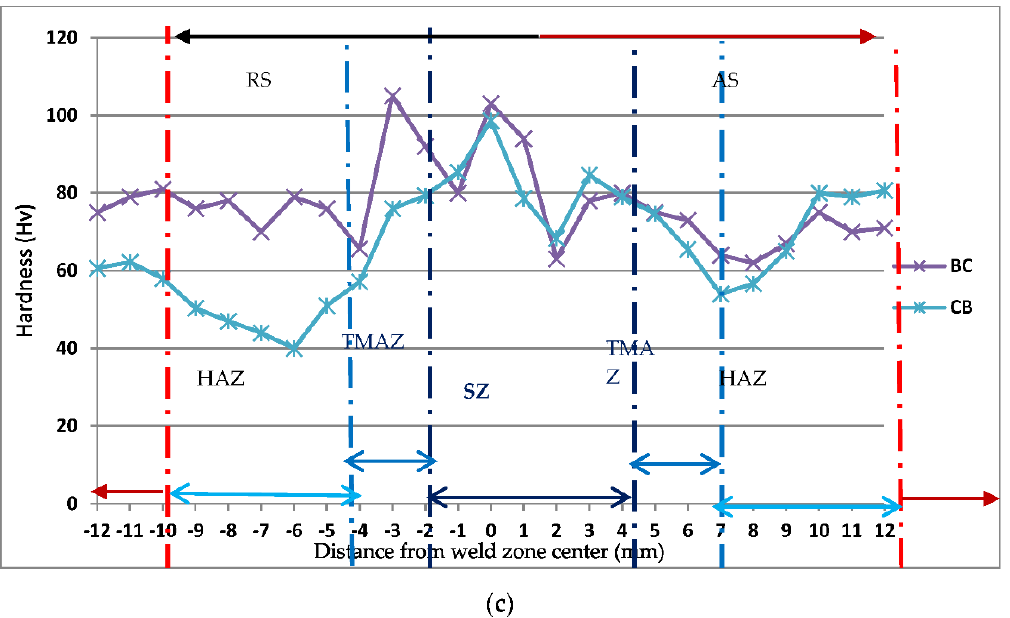
Figure 3. Microhardness of dissimilar joints attained by FSW ( a ) AA6061 and AZ31B and AZ31 and AA6061, ( b ) AA6061 and AZ91 and AZ91 and AA6061, ( c ) AZ91 and AZ31B and AZ31B and AZ91.